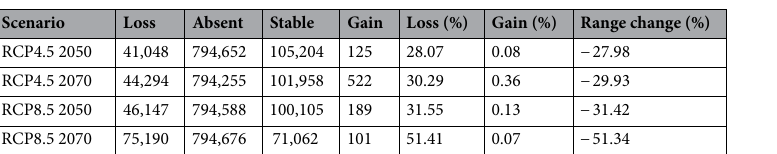
(Fig. 8A–D; Table 7). The principal component analysis revealed that the variation retained by principal compo- nent 1 (PC1) ranged from a minimum of 48.99% in case of current vs RCP 8.5-2050 comparison to a maximum